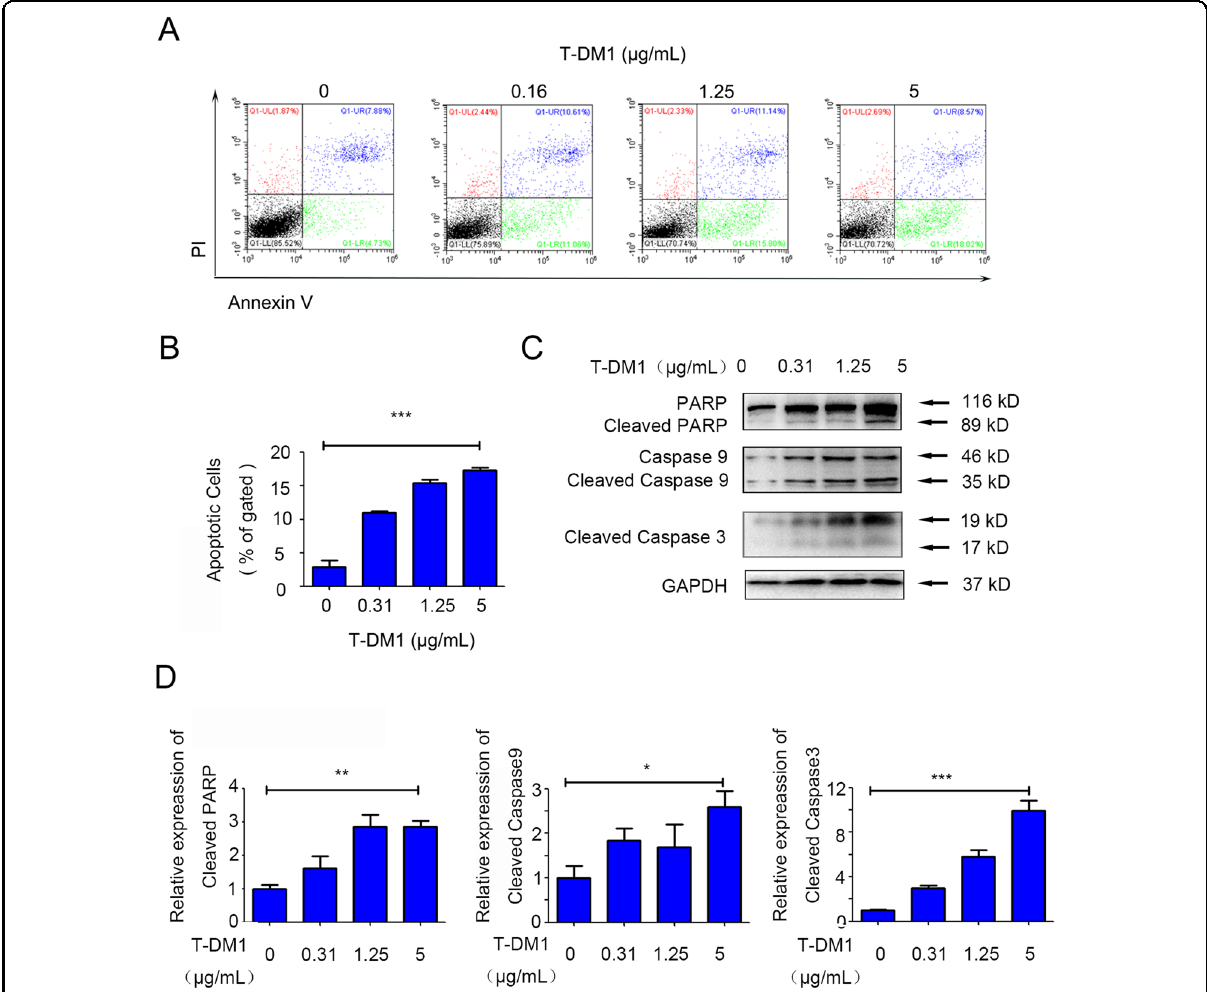
Fig. 2 Caspase-dependent apoptosis was induced in both gastric cells by different concentrations of T-DM1. A Apoptosis of NCI-N87 cells incubated with T-DM1 for 48 h was evaluated with Annexin V and PI staining and measured by FCM. B The percentage of apoptotic cells (Annexin V + ) is shown in bar charts. Data are expressed as the mean ± S.D. (*** P < 0.001, n = 3). C HER-positive NCI-N87 cells were incubated with T-DM1 for 48 h. The levels of cleaved PARP and caspase 9/3 were measured by immunoblot analysis. d ImageJ software was employed to calculate the densitometric values of NCI-N87 cell samples and normalize the densitometric values to the corresponding control value. The results of the control were set as 1.0, and the values are presented as the mean ± S.D. of 3 independent experiments. Student ’ s t -test. * P < 0.05, ** P < 0.01, and *** P <